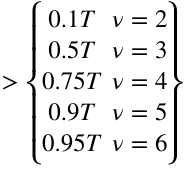
4 The Chaotic Antlion Algorithm (CAA) Figure 2 is a flowchart of the chaotic antlion algorithm(CAA). CAA first uses the PWLCM chaotic map to initialize the positions of ants and antlions, and then uses a quasi-opposite learning strategy to optimize the positions of the two, increasing the diversity of the population. Then, the random walk behavior of the ants uses the chaotic strat- egy to increase the search range, so that the algorithm can jump out of the local optimal solution. At the same time, the walking scale of ants is reduced according to the prin- ciple of 1/5, which speeds up the chaotic walking speed of ants. Finally, after the ants are successfully captured, the quasi-opposite learning strategy is used again to optimize the position of the antlion, which improves the accuracy of the algorithm optimization. The pseudocode for CAA is described in detail in Algorithm 1. The following sub- sections detail the different components of the